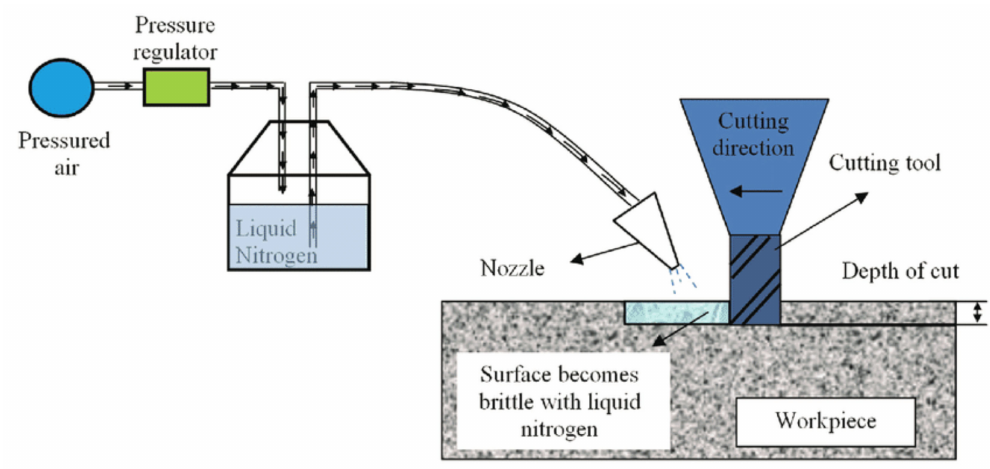
Figure 12. Diagram of cryogenic cooling technique setup, reprinted with permission from ref. [64]. Copyright 2010 Elsevier